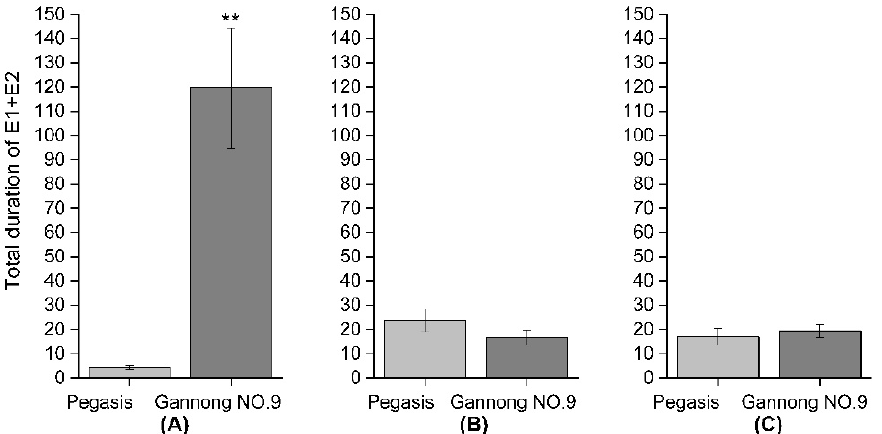
Figure 6. Total duration of stylet activity in phloem (E1 + E2) of ( A ) cowpea aphid (CPA), ( B ) pea aphid (PA), ( C ) spotted aphid (SAA) (** Indicates the difference is significant, p < 0.05).